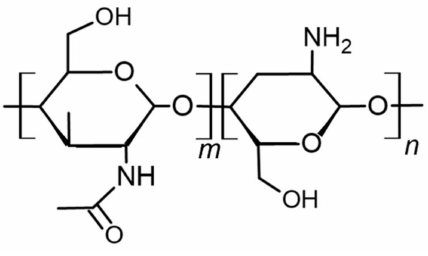
Figure 1. Chemical structure of